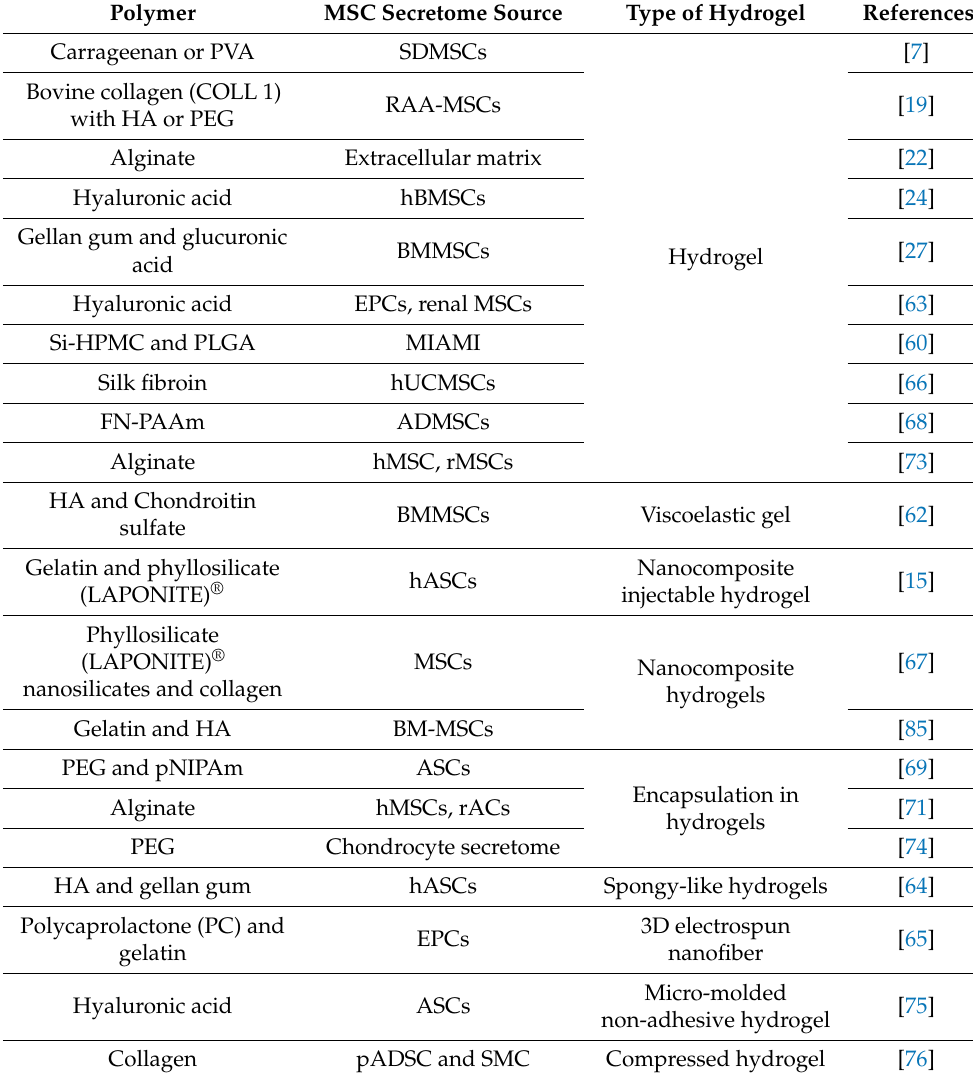
Table 2. Some hydrogel-forming polymers for MSC secretome